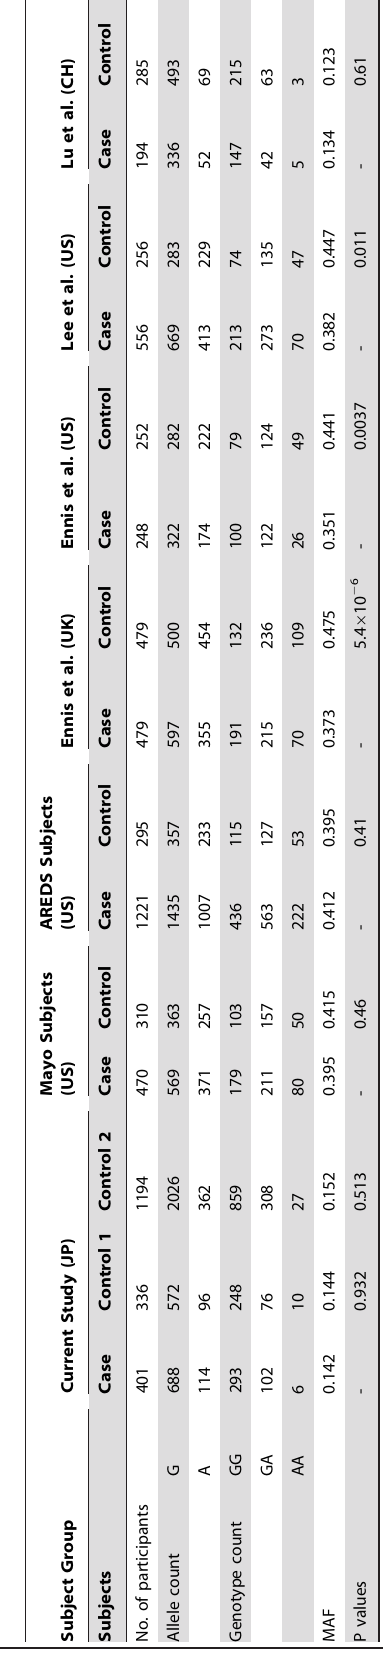
Table 3. Odds Ratios in Various Genetic